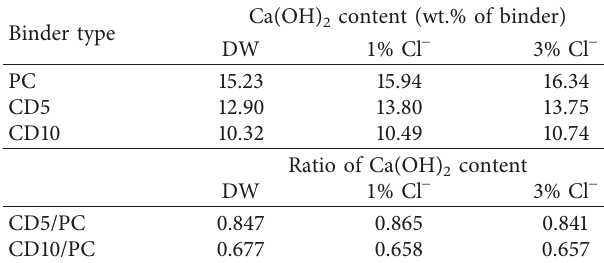
Table 5: Ca(OH) 2 content of PC, CD5, and CD10 at 28